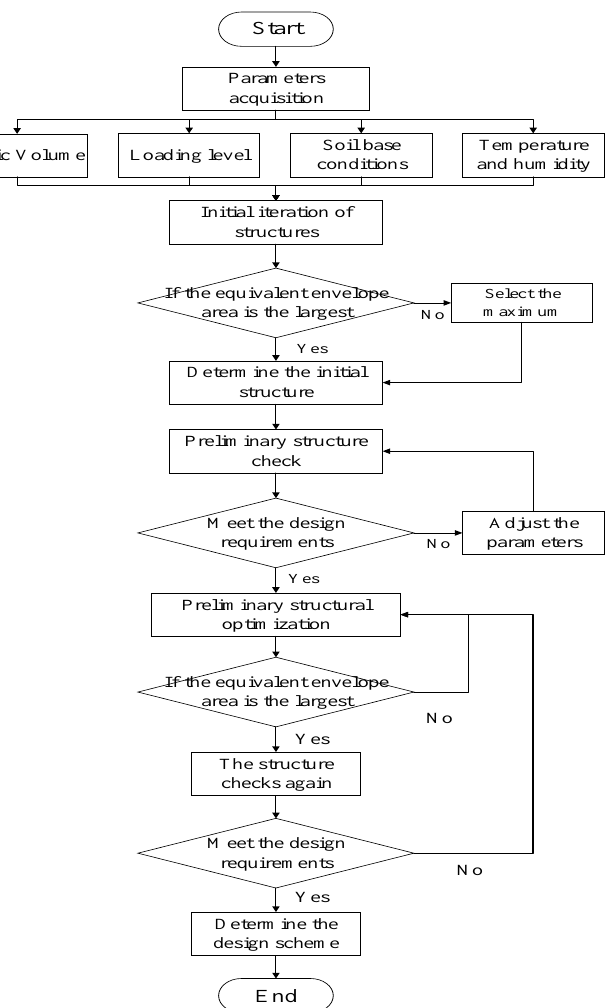
Figure 9. Flowchart of pavement structure design.